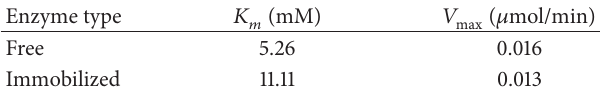
Figure 6: Effect of temperature on the activity of free and immobi- lized form of laccase. Table 1: Kinetic constants of the free and immobilized